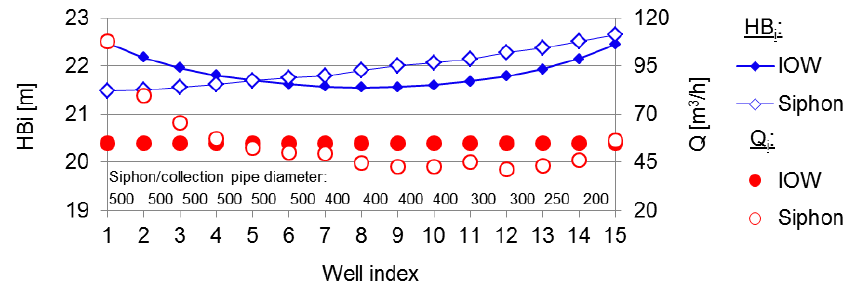
Figure 6. Calculated well heads and flow rates for IOW and siphon wells using SIPHON.